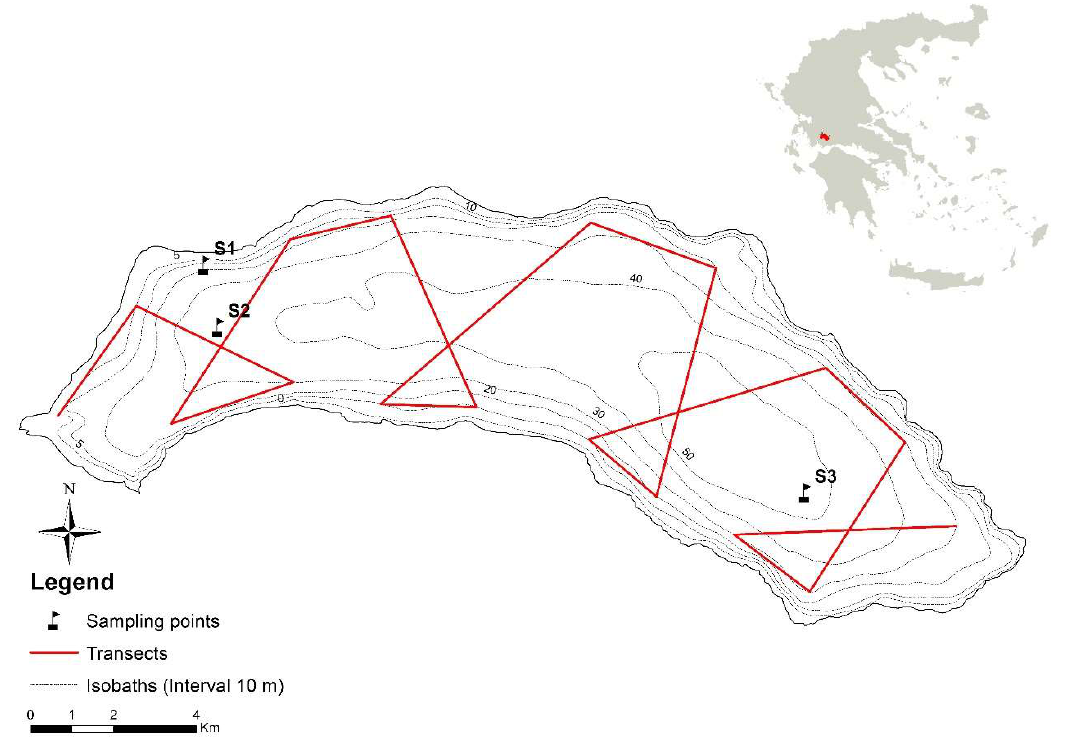
Figure 1. Depiction of the study area and lake bathymetry (derived from the digitization of 1:50,000 scale topographic maps, which constitute an appropriate reference source for such geomorphometric information [35,36]) with the hydroacoustic survey and the sampling points overlaid.